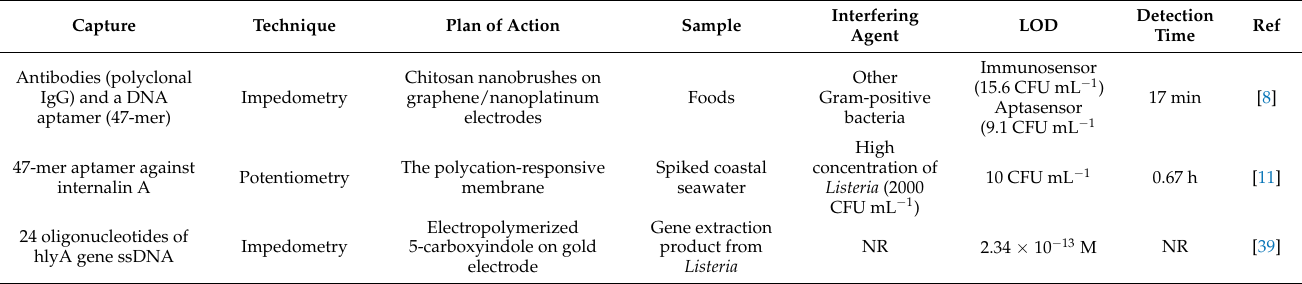
Figure 4. A schematic illustration of a genosensor with integrated electrodes that sense target DNA using a double linear hybridization chain reaction (DL-HCR) technique and short signal DNA probe pairs. ( A ) Graphical presentation of the developed chip and ( B ) Preparation steps of the genosensor. Copyright (2022) from ACS publications [70]. Table 2. Genosensors have been used for the detection of Listeria monocytogenes